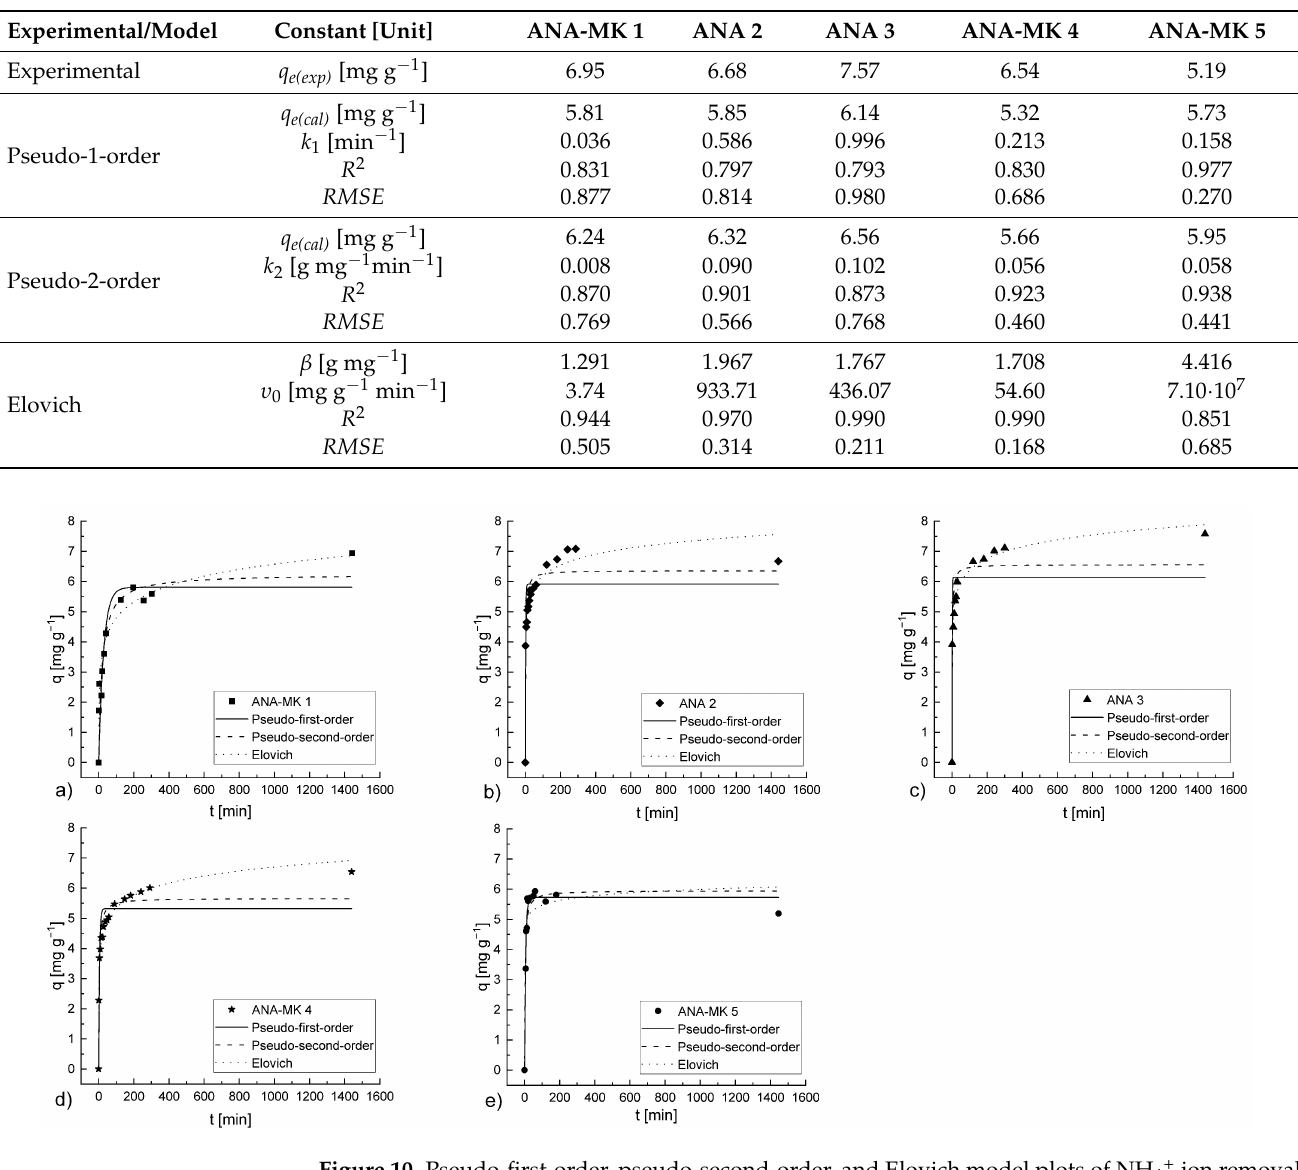
Table 7. Pseudo-first-order, pseudo-second-order, and Elovich model parameters for the alkali- activated analcime sorbents used for NH 4+ ion removal.